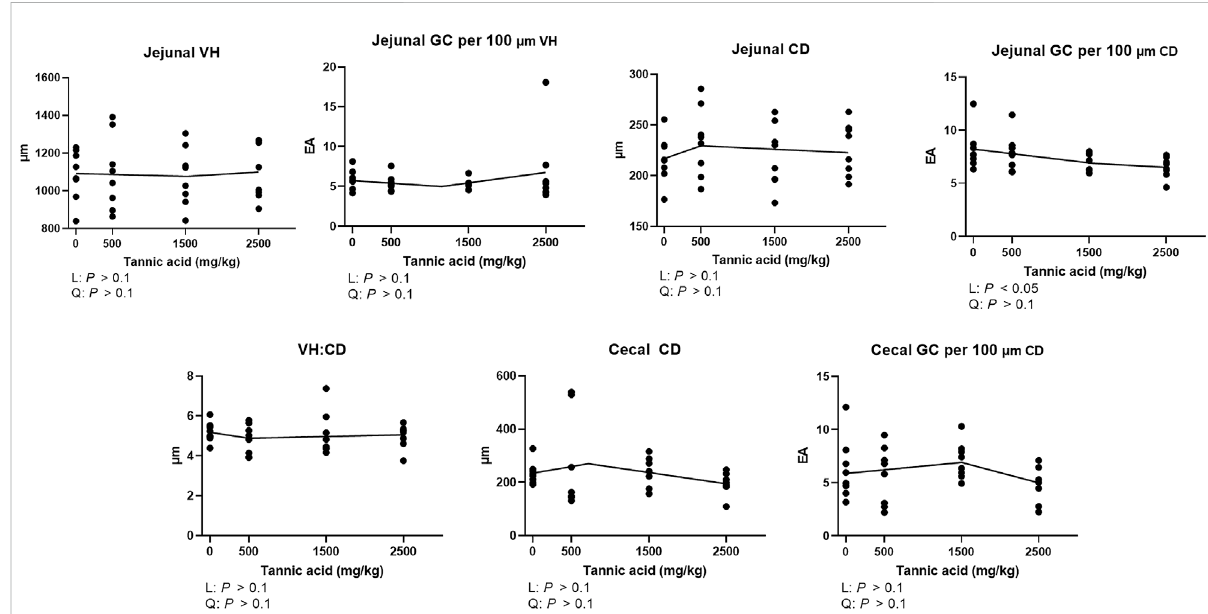
FIGURE 3 Jejunal morphology [villus height (VH), crypts depth (CD), and VH:CD] and goblet cell (GC) counting per 100 μ m VH and CD and cecal CD and goblet cell counting per 100 μ m CD in broiler chickens fed different concentrations (0, 0.5, 1.5, and 2.5 g/kg) of tannic acid on D 21. The treatment groups were compared using one-way ANOVA followed by the Tukey ’ s multiple comparison. Different superscripts differ at p < 0.05. Orthogonal polynomial contrasts analysis was conducted to see linear pattern (L) andquadratic pattern (Q)among thetreatments.To calculatetheoptimal dosage of tannic acid in broilers, segmented linear regression was conducted, and X0 (in fl ection point) with p values for slope 1 (lower than X0 ) and slope 2 (higher than X0 ) were